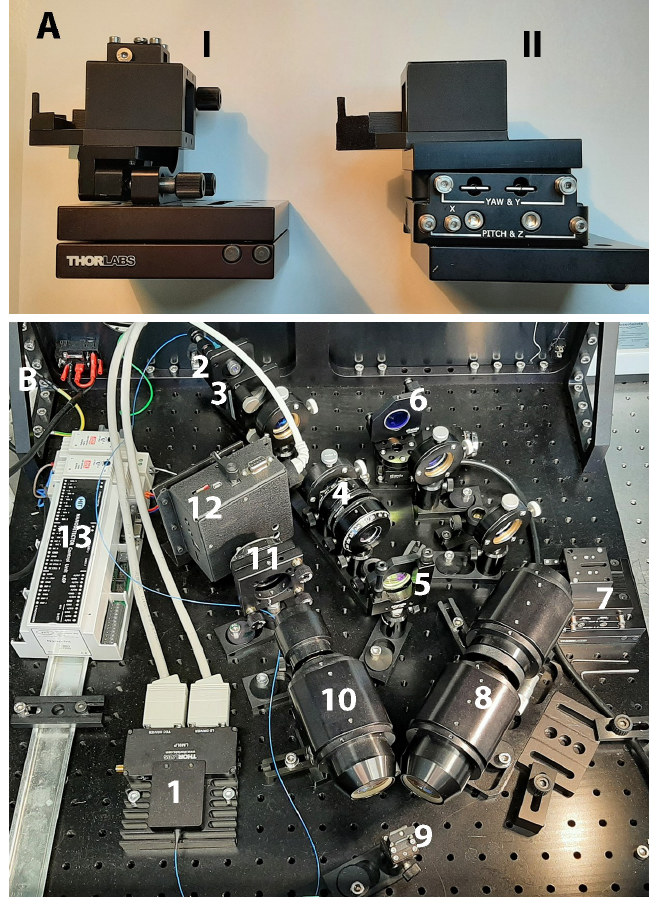
Figure 3. ( A ) (I) the prism and flow cell holder created for the modified version of the SPR microscopy sensor in the scope of the EC-FP7 project ”Nanodetector”, and (II) the improved version of such a holder, which includes a 5-axis platform; the 5-axis platform helps to fine-tune the prism and flow cell positions near the objective; ( B ) the internal view of the SPR microscopy sensor developed in the scope of the EC-FP7 project ”Nanodetector”. The following elements are presented: (1) an SM- fiber-coupled laser diode, (2) a diode head, (3) a concave lens, (4) a p-polarizer, (5) a mirror, (6) a scanning mirror mounted onto the motorized rotation stage, (7) a prism and flow cell holder, (8) and (10) focusing lenses (objectives), (9) a diffraction grating, (11) a CCD or CMOS image sensor chip, (12) a BeagleBoard-xM computer (www.beagleboard.org, accessed on 2 April 2023), (13) a